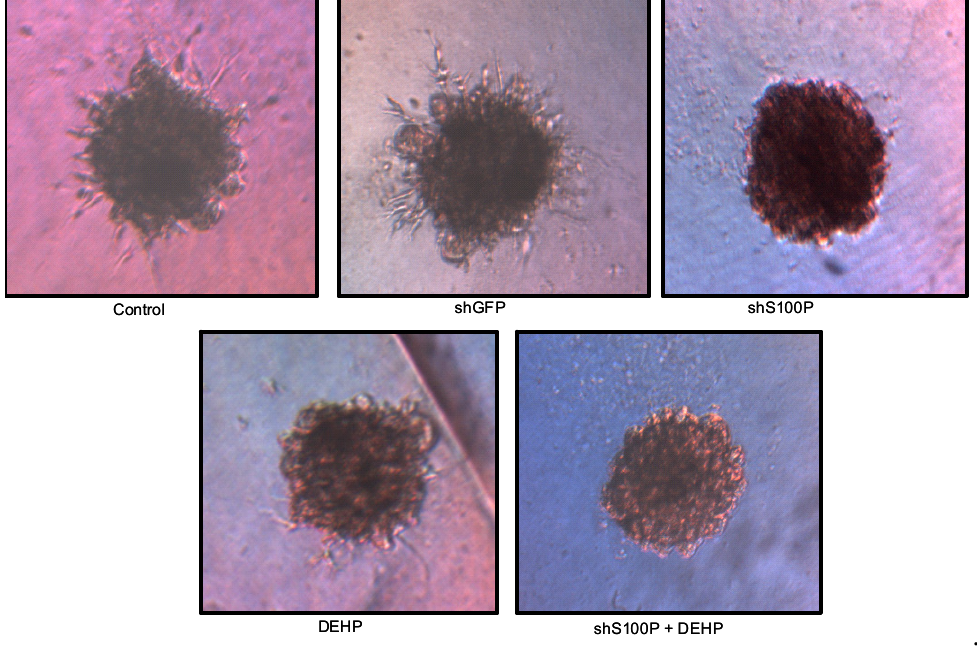
Figure 6. Representative micrographs of spheroid colony formation by LN-229 cells treated with DEHP alone and in combination with S100P knockdown. Microphotographs were taken after seven days of